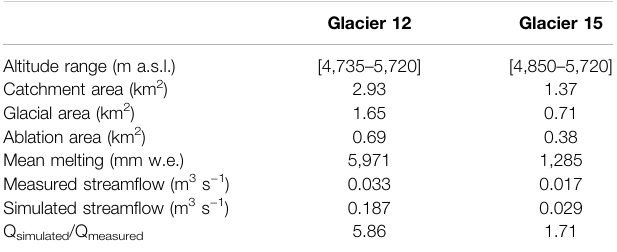
TABLE 5 | Comparisons of hydrological features between Antisana Glacier 12 for 2012yearusing distributedSEB pluslinear reservoirs and Antisana Glacier 15 for 1995 – 2005 period using semi empirical approach taken from Favier et al. (2008). Glacier 12 Glacier 15 Altitude range (m